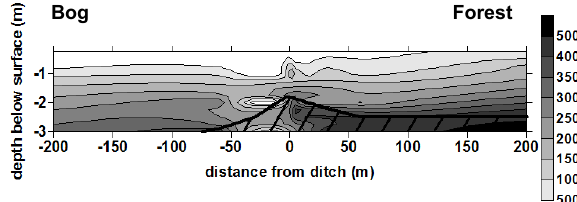
Fig. 6. Mean chloride concentrations in µmolL − l in the pore water across the transect. Peat depth is vertically